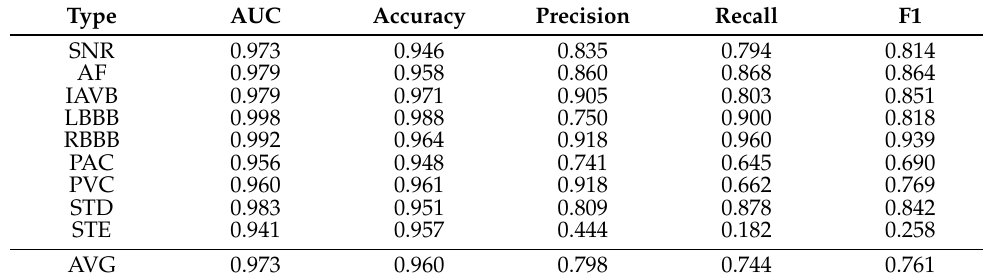
Table 9. Results produced by the proposed model without the CoT block on the CPSC2018